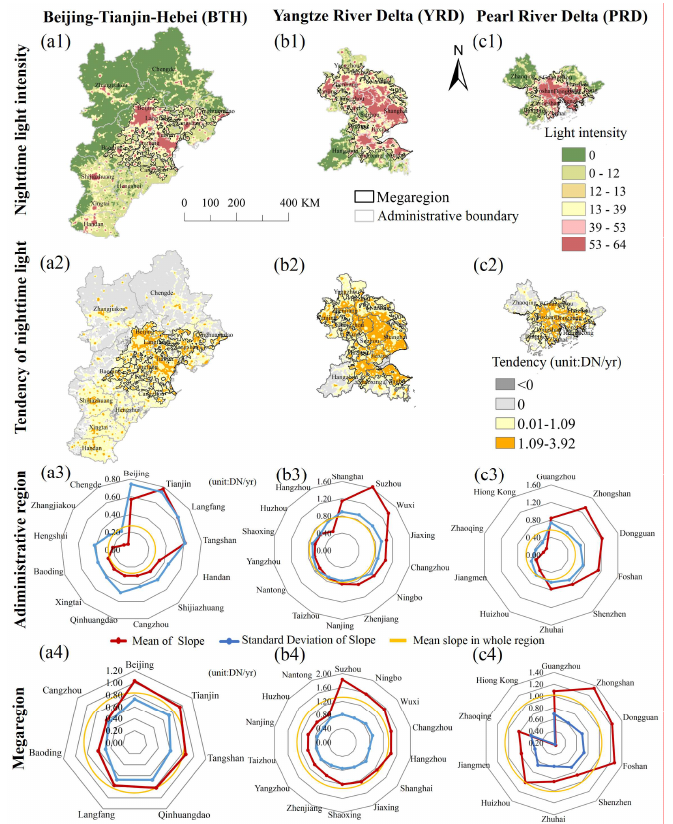
Figure 2. Geographical distribution of calibrated light intensity in 2013 (upper row: a1 – c1 ), 22 years linear regression tendency of light intensity (from 1992 to 2013 in DN/yr , second row: a2 – c2 ), and statistics of linear regression tendency for individual cities in both administrative (third row: a3 – c3 ) and megaregion (bottom row: a4 – c4 ) boundaries.